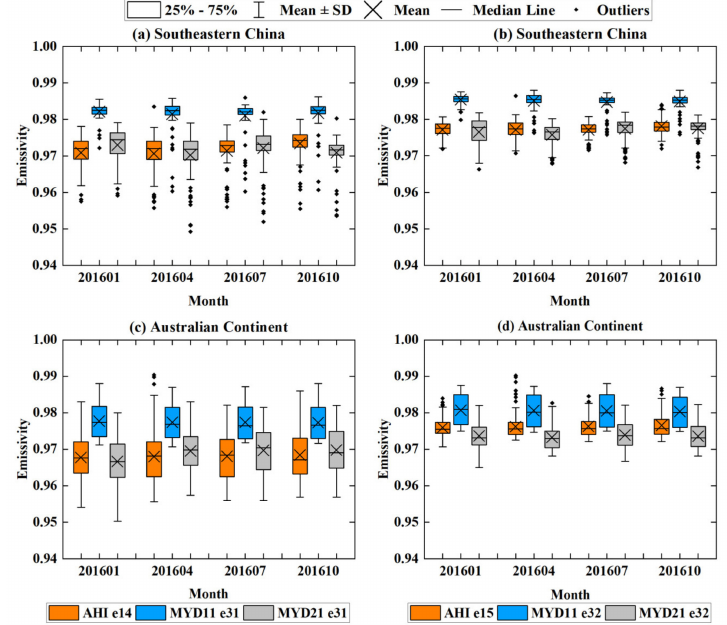
Figure 7. Daytime emissivity values of AHI in bands 14 and 15 and of MYD11 and MYD21 in bands 31 and 32 over the two study areas. ( a , b ) Southeastern China results and ( c , d ) Australian continent results.